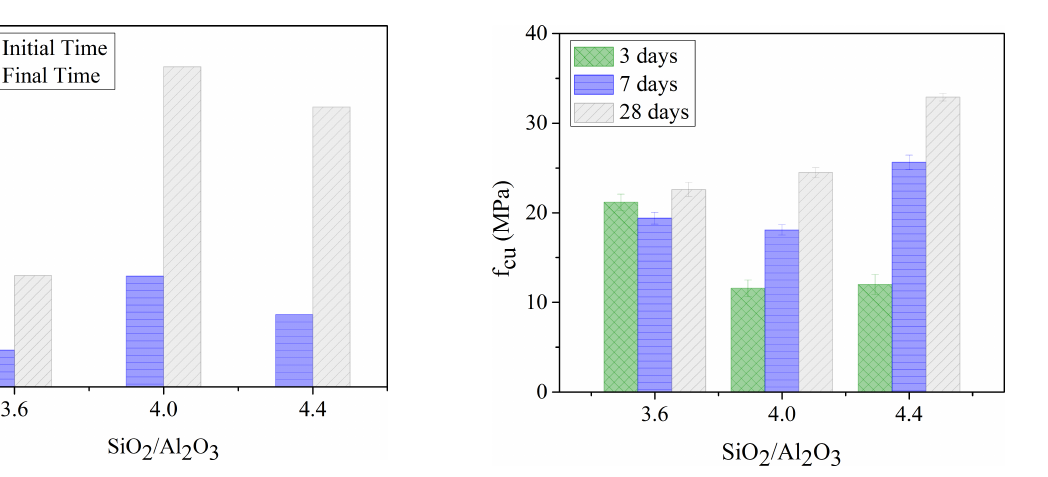
Figure 6: Effect of S/A molar ratio on compressive strength In Figure 6 samples with lower S/A molar ratio S3.6 recorded a compressive strength up to 20 MPa in 3 days of curing, while the strength in 7 and 28 days remained fairly static. Stability of strength for S3.6 precursors at late ages could be because most of the aluminosilicate gel was formed at an early stage due to the low amount of silica. Other samples with higher S/A molar ratio (S4.0 and